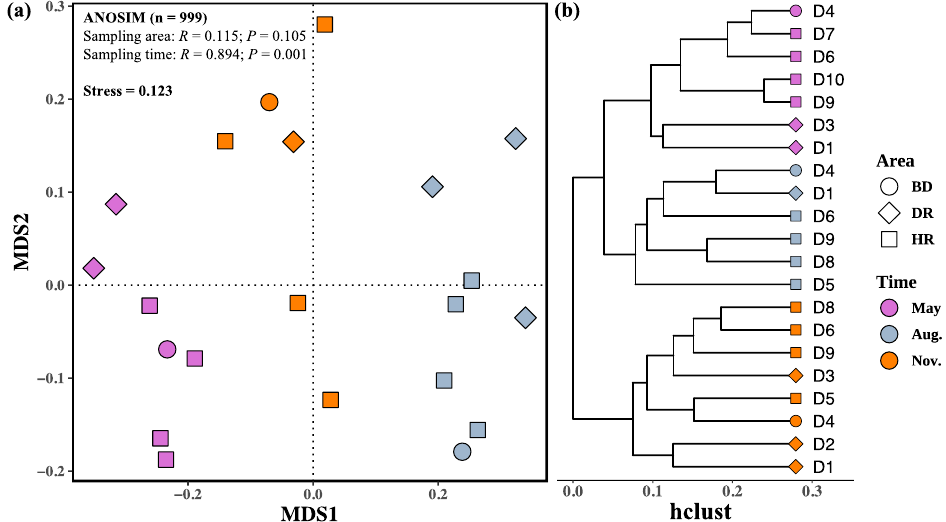
Figure 5. Plots of multivariable analysis results for the zooplankton in DJKR. ( a ) Nonmetric Multidi- mensional Scaling (NMDS) analysis (Stress < 0.2), and results of Analysis of Similarities (ANOSIM) are